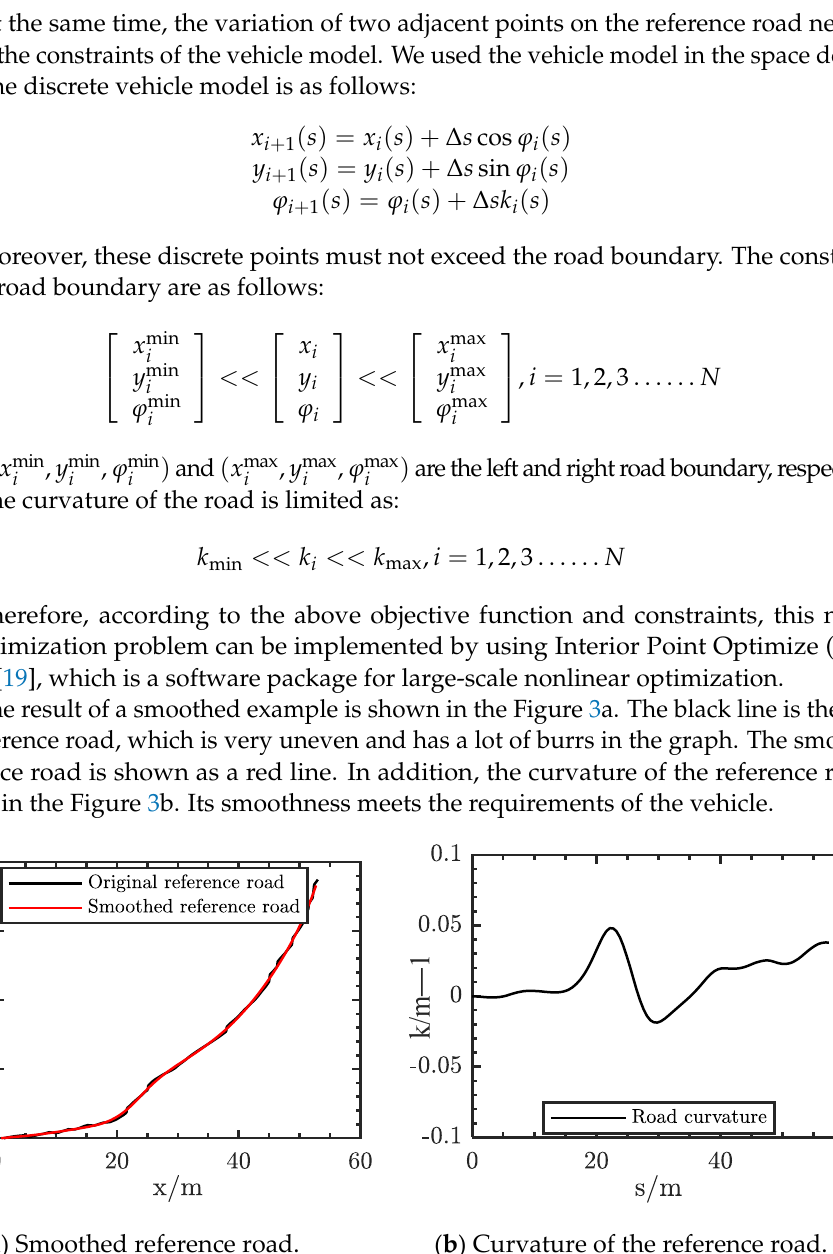
Figure 3. Results of reference road smoothing .